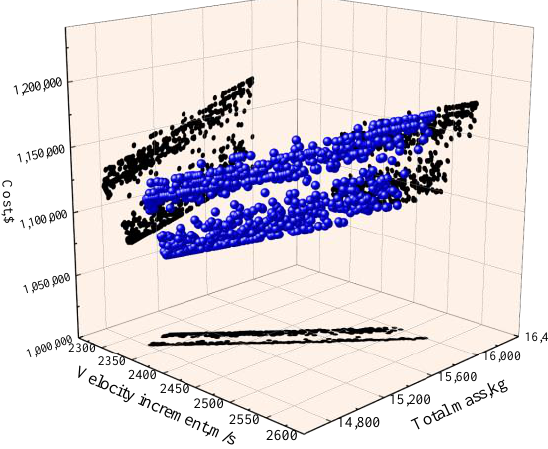
Figure 12. Feasible solution set of LRE-LK.